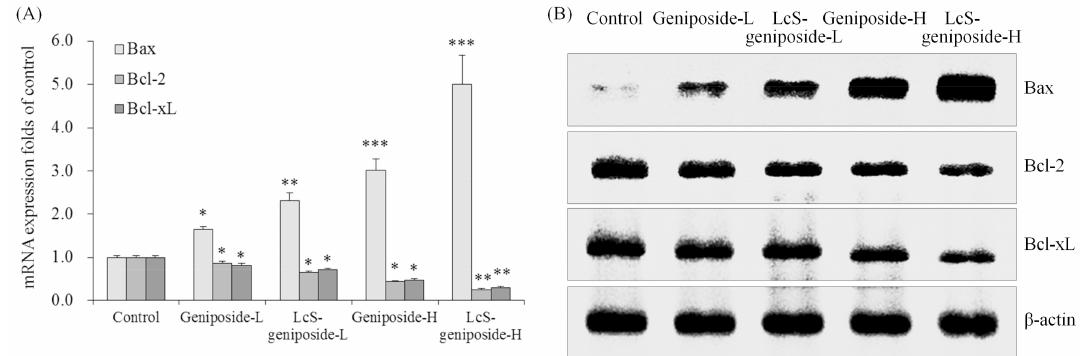
Figure 4. The mRNA ( A ) and protein ( B ) expressions of Bax, Bcl-2 and Bcl-xL in human oral squamous carcinoma HSC-3 cells. * p < 0.05, ** p < 0.01, *** p < 0.001 vs. the control group. Geniposide-L: 25 µ g/mL geniposide; LcS-geniposide-L: 1.0 × 10 6 CFU/mL LcS + 25 µ g/mL geniposide; Geniposide-H: 50 µ g/mL geniposide; LcS-geniposide-H: 1.0 × 10 6 CFU/mL LcS + 50 µ g/mL